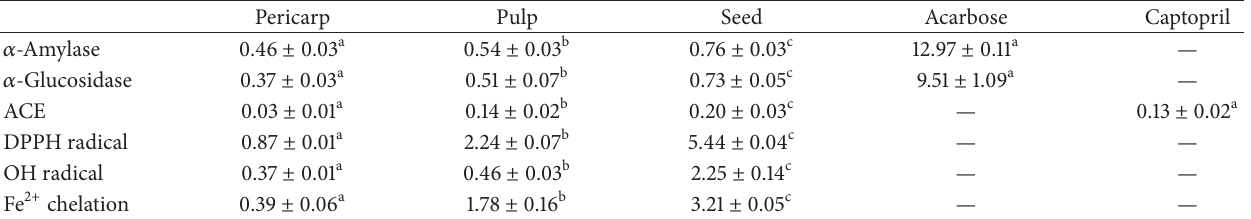
Values represent means ± standard deviation of triplicate readings. Values with the same superscript letter along the same row are not significantly different ( 𝑃 > 0.05 ).